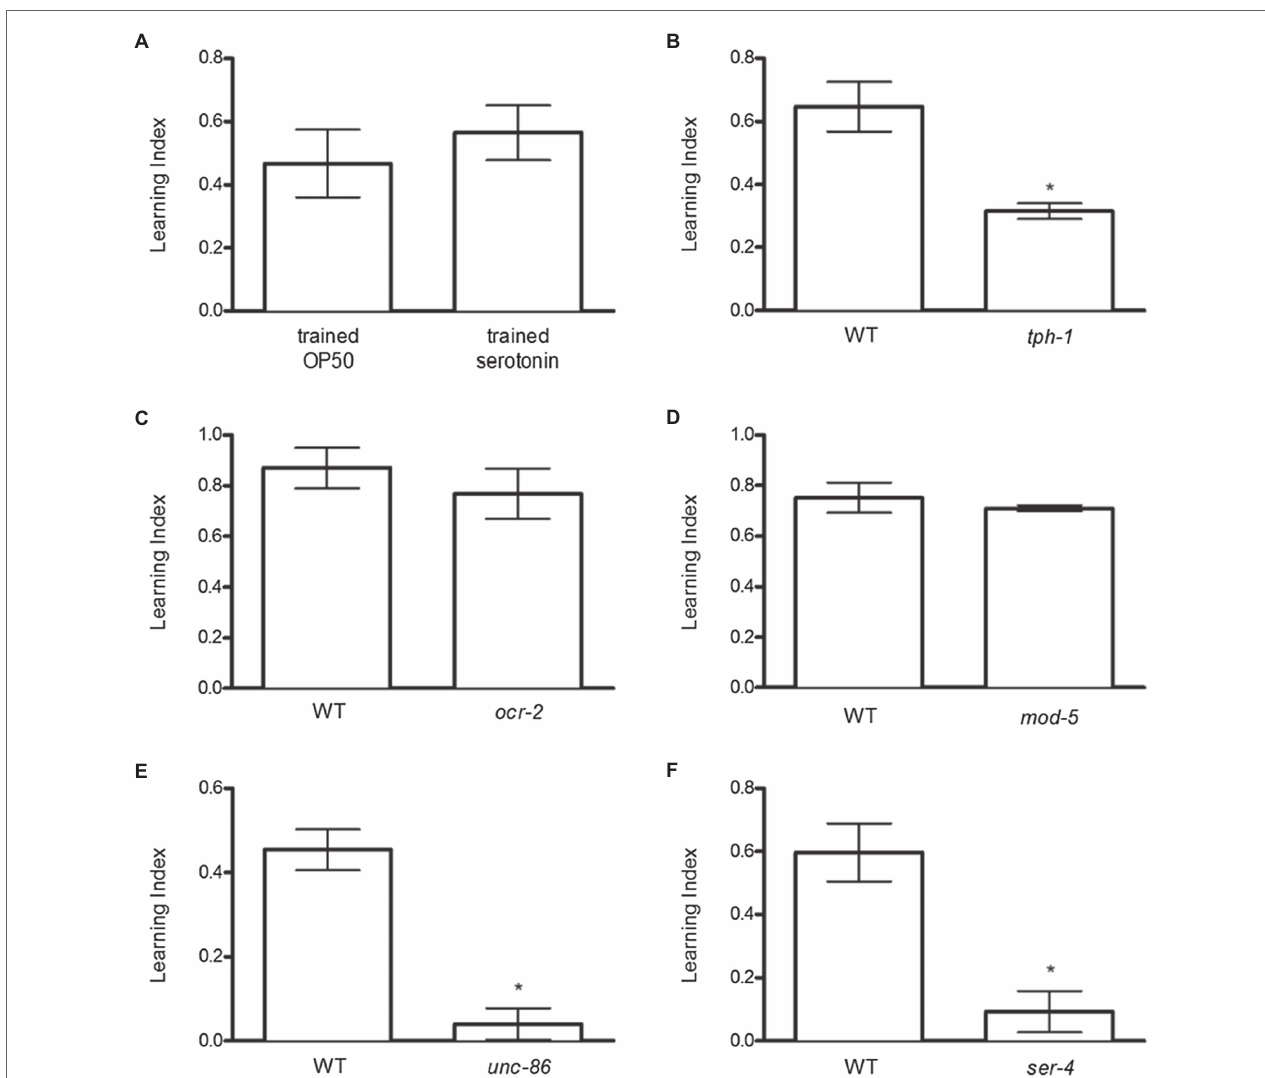
FIGURE 2 | Serotonin (released from NSM neurons) signaling through 5-HT4 receptor increases food-induced odor preference. (A) Serotonin increased odor preference similar to OP50. (B) tph-1 mutant animals exhibited deficits in odor preference development. (C) ocr-2 and (D) mod-5 mutant animals increased odor preference, similar to N2 animals. (E) unc-86 mutant animals displayed deficits in food-induced odor preference development. (F) ser-4 mutant animals exhibited deficits in odor preference compared to N2 animals. * p < 0.05 ( t test). Each column represents at least 3 independent trials, using approximately 50–150 animals per